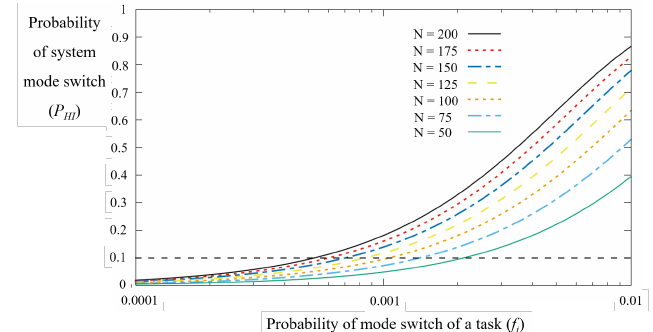
Figure 11. The probability of mode switch w.r.t. task mode switch probability and the number of